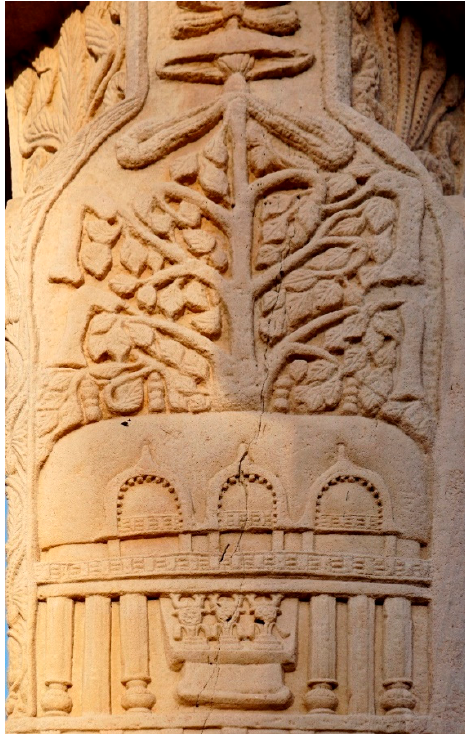
Figure 7. Photo by Photo Dharma from Sadao, Thailand, CC BY 2.0 (Wikimedia Commons).